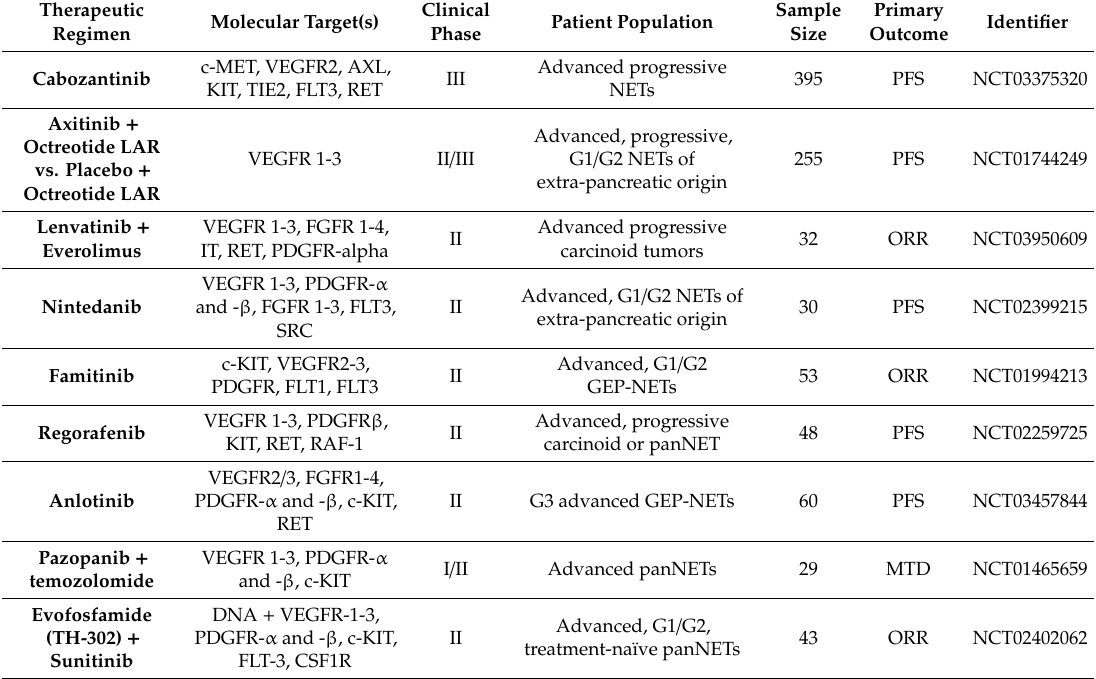
Table 2. Ongoing clinical trials of TKIs in patients with